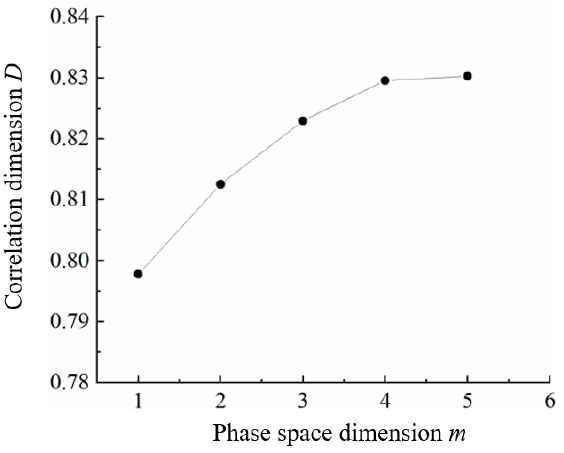
Figure 7. Relation curve of phase space dimension m and correlation dimension D .